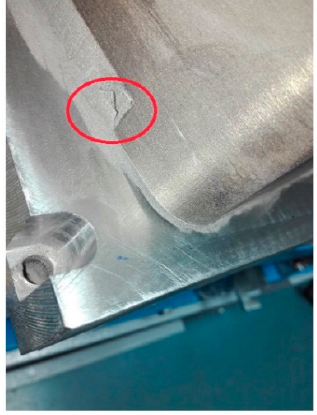
Figure 5. Damaging of the manufactured shaped intermediate piece during manufacturing under the influence of internal stress.